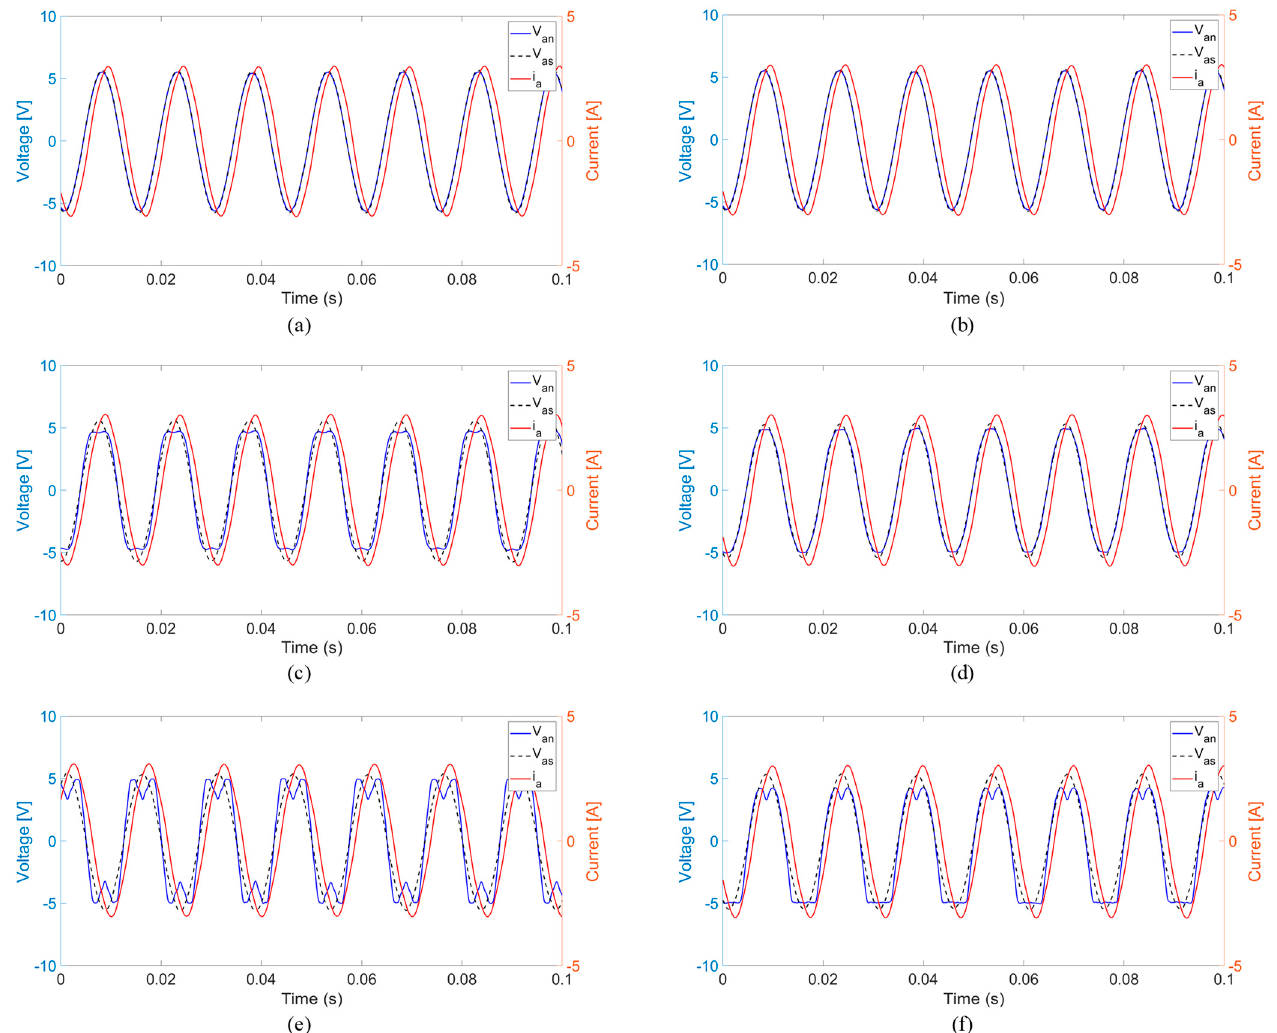
Figure 17. Experimental results at 1000 rpm and 3 A depending on the PWM technique: ( a ) SPWM; ( b ) THPWM; ( c ) SVPWM; ( d ) 60° DPWM; (e) 30° DPWM; ( f ) 120° (off) DPWM.